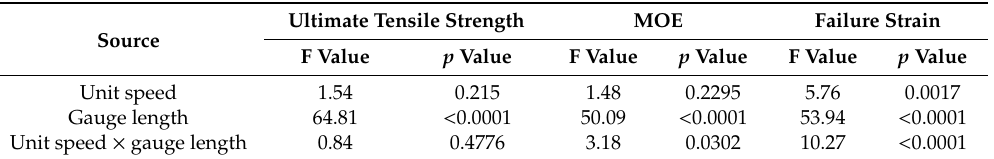
Table 5. Summary of analysis of variance (ANOVA) results obtained from the general linear model (GLM) performed on two factors for each of three tensile properties.